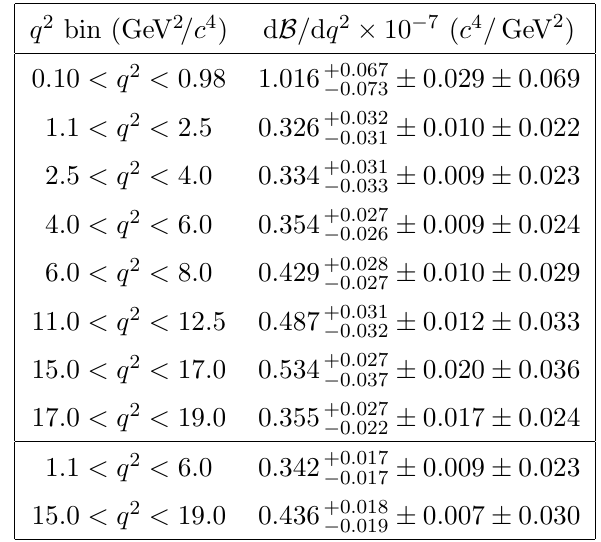
Table 2 . Di(cid:11)erential branching fraction of B 0 ! K (cid:3) (892) 0 (cid:22) + (cid:22) (cid:0) decays in bins of q 2 . The (cid:12)rst uncertainty is statistical, the second systematic and the third due to the uncertainty on the B 0 ! J= K (cid:3) 0 and J= ! (cid:22) + (cid:22) (cid:0) branching fractions. Open